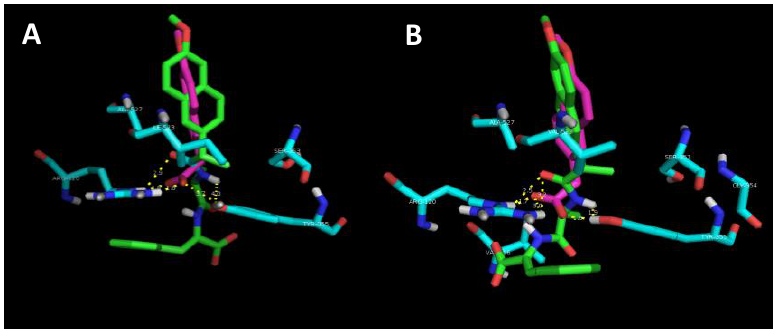
Figure 7. Images for the best docking conformations (lowest interaction energy) of compound 4 (green) and naproxen (pink) in the binding site of COX-1 ( A ) and COX-2 ( B ) isozymes. The amino acid residues which interact with the inhibitors are coloured blue and the hydrogen bonds are represented as yellow dashed lines. Table 2. Binding energy for the best docking conformations of compound 4 and naproxen in the binding site of COX-1 and COX-2 isozymes.